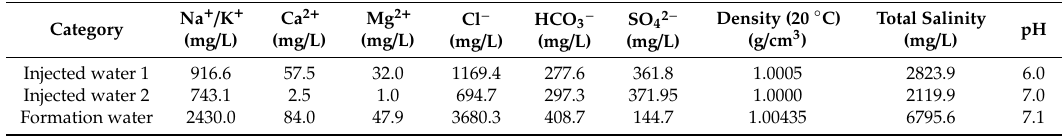
Table 1. Hydrochemical characteristics of di ff erent water sources in block M.